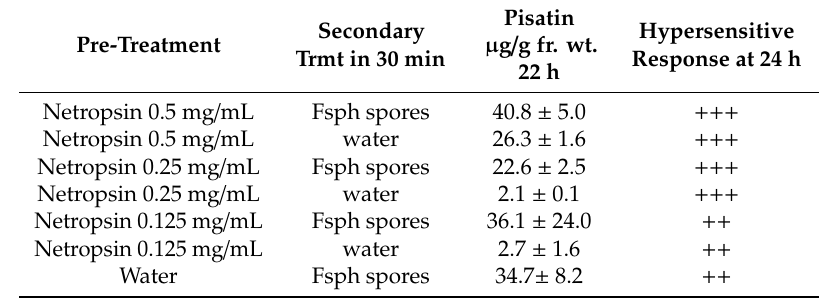
Table 1. The interaction of Netropsin with spores of Fusarium solani f. sp. phaseoli (Fsph spores) on the production of the phytolexin, pisatin. Pea endocarp tissue was pretreated with 20 µ L water or netropsin concentrations were followed after 30 min by 20 µ L of Fsph spores (4 × 10 6 / mL) or water. Treatments were replicated twice. Pisatin was extracted from endocarp tissue after 24 h with hexane and quantitated at 309 nm (see Methods). + indicates the observed intensity.